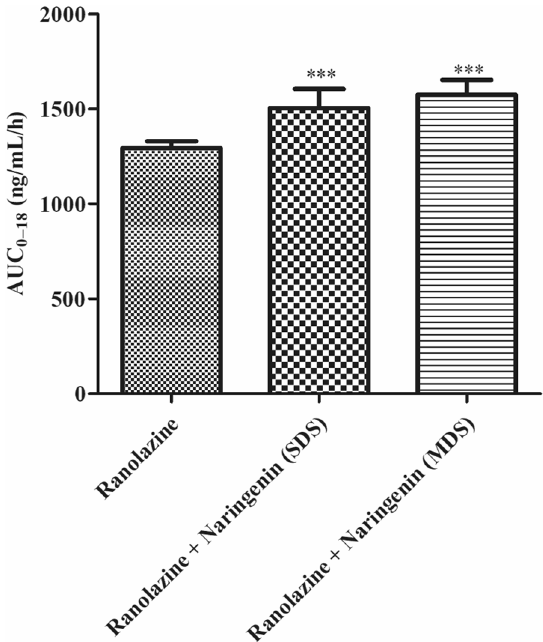
Fig. 4 The movement of ranolazine from the serosal to the mucosal side of the rat-everted ileum ( n 6) in the presence and absence of = naringenin. R, ranolazine; N,